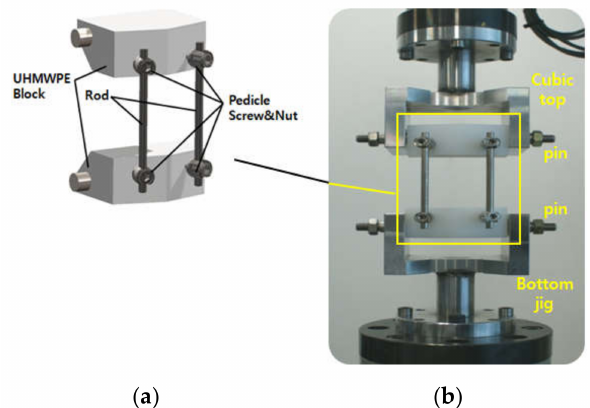
Figure 3. Experimental setup for bending strength testing: ( a ) The fused structure and ( b ) the material testing machine with the